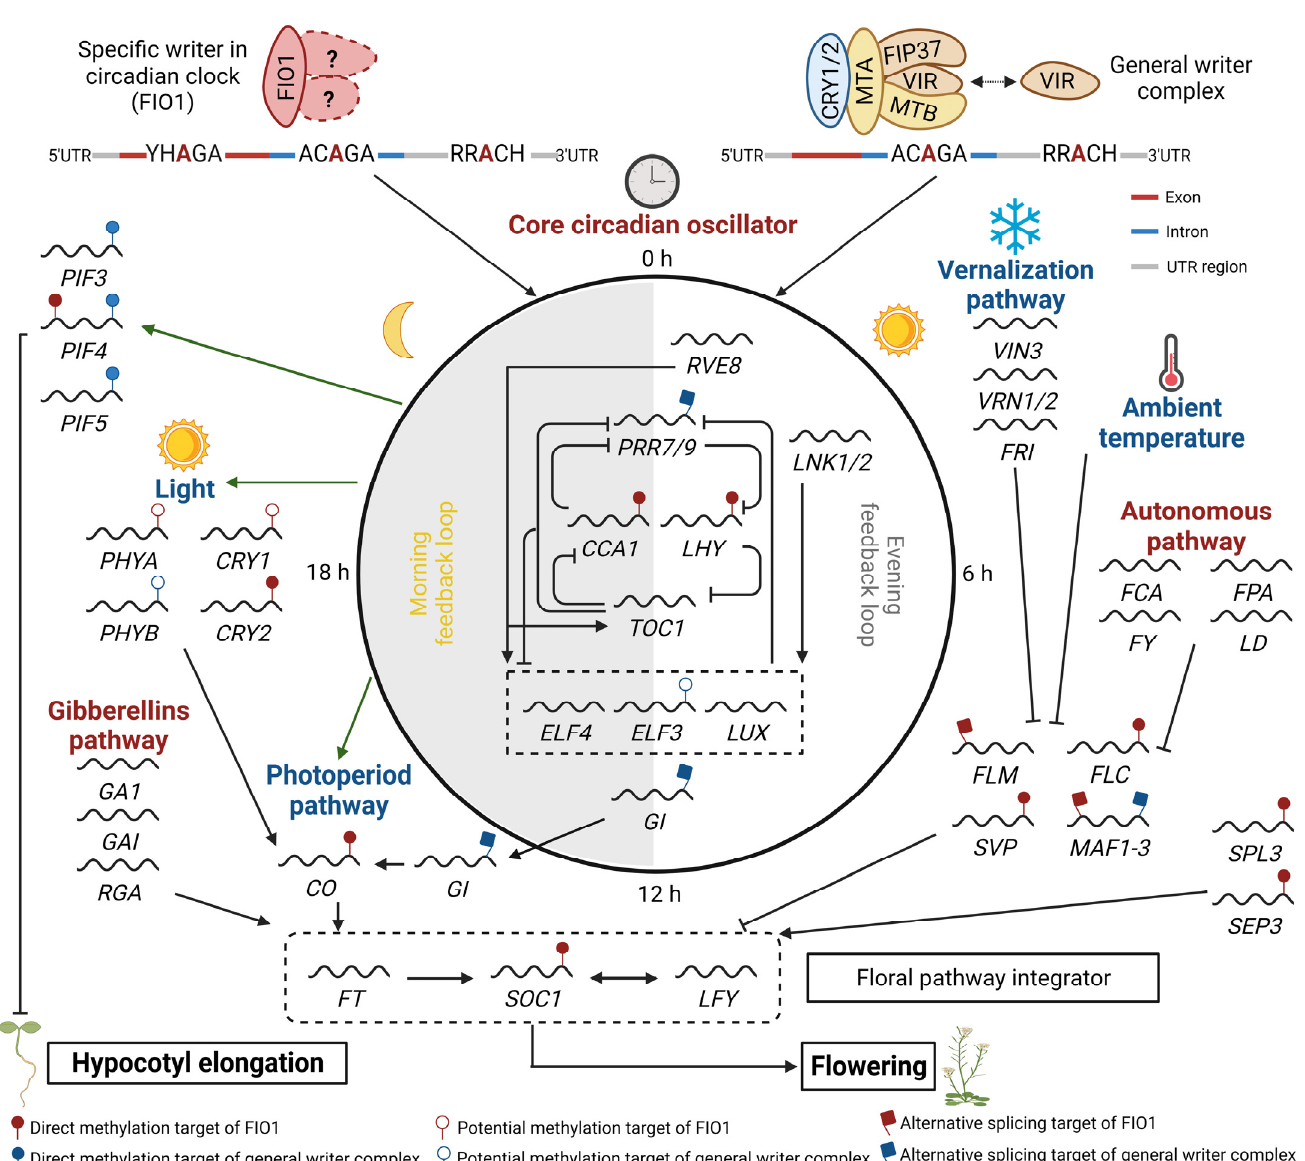
Figure 2. A proposed model depicting the involvement of FIO1 and general m 6 A writer complexes in regulating circadian clock, flowering, and hypocotyl elongation in Arabidopsis. Diverse pathways respond to various external (photoperiod, vernalization, and ambient temperature) and internal (autonomous, gibberellins, and circadian oscillator) stimuli/signals to regulate these processes are shown in red and blue, respectively (adapted from [111] ). FIO1 prevents premature flowering and maintains the circadian period by affecting the expression level, splicing, and/or stability of several key circadian clock transcripts (e.g., LHY and CCA1 ), flowering regulator transcripts (e.g., SOC1 and FLC ), and photomorphogenesis-related genes (e.g., PIF4 ) through direct m 6 A methylation of the 3 ′ UTR and a subset on the CDS region, or indirectly through m 6 A methylation of U6 snRNA. The general m 6 A writer complex (including MTA, MTB, FIP37, VIR, and HAKAI) recognition motifs are mainly present in the 3 ′ UTR region. PIF37 can interact with cryptochromes (CRY1) and increases the m 6 A modification of PIF3 , PIF4 , and PIF5 , which consequently reduces their RNA stability and promotes photomorphogenesis [112] . However, CRY2 recruits MTA, MTB, and PIF37 to methylate several core circadian clock genes and enhances their mRNA stability [62] . The involvement of other m 6 A writer components such as VIR and HAKAI in the regulation of these processes requires further investigation.